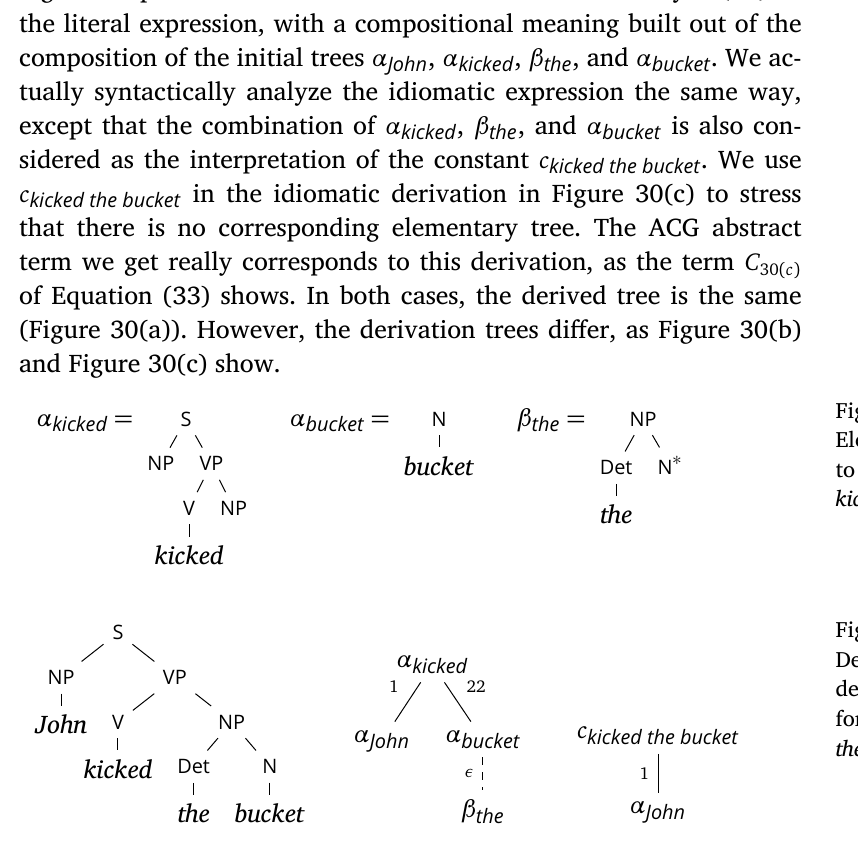
Figure 30: Derived tree and derivation trees for John kicked the